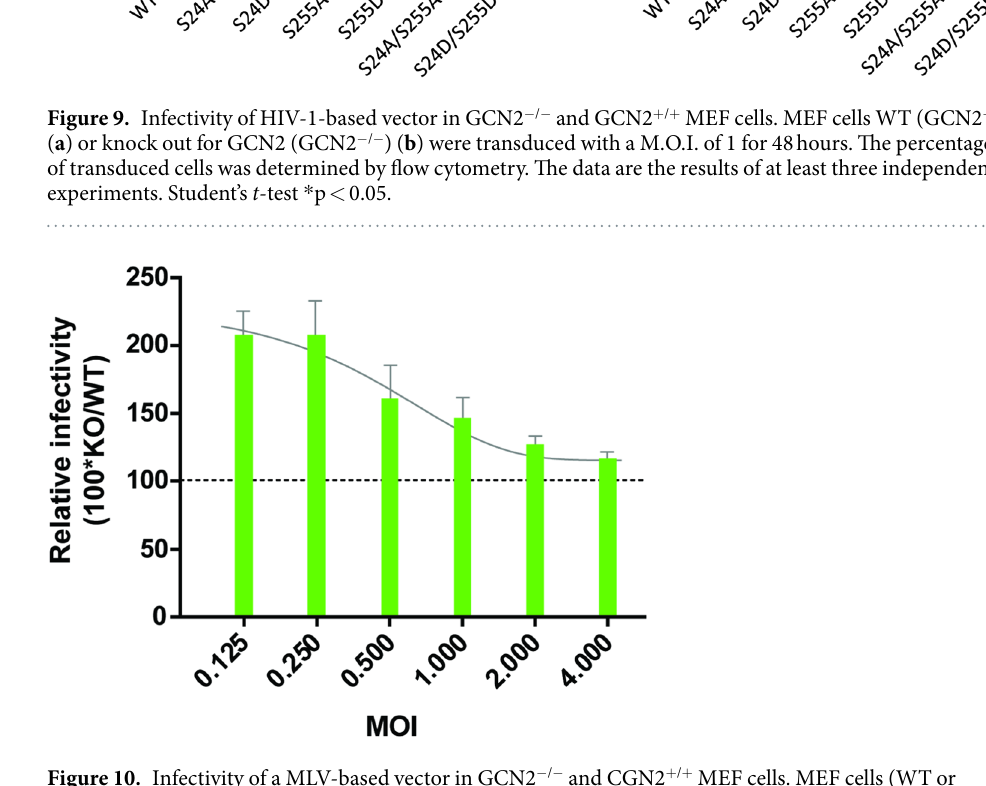
Figure 10. Infectivity of a MLV-based vector in GCN2 − / − and CGN2 + / + MEF cells. MEF cells (WT or GCN2 − / − ) were transduced with M.O.I. from 0.125 to 4. The percentage of transduced cells was determined by flow cytometry. For each point, the relative infectivity was determined as the level of GFP + cells in GCN2 − / − MEFs normalized to the level in GCN2 + / +